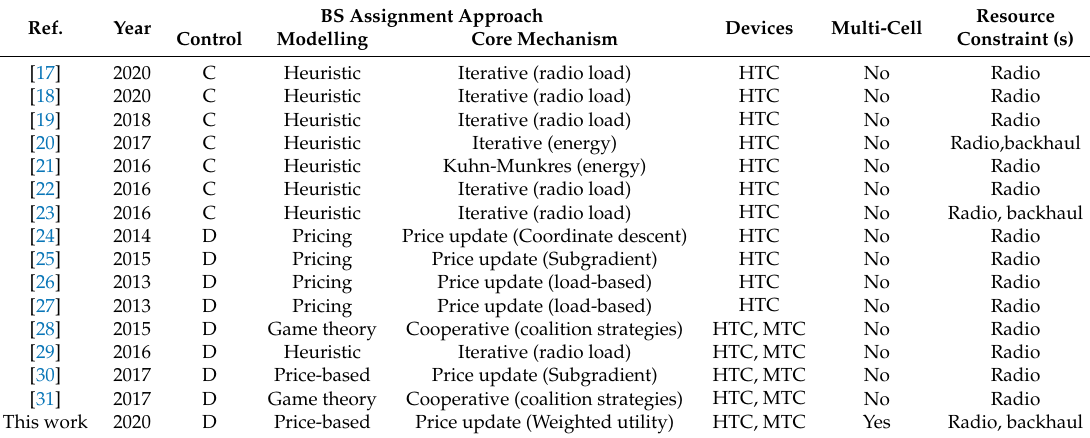
Figure 1. Generic access network architectures under ( a ) centralized and ( b ) distributed paradigms. Table 1. Summary of base station (BS) assignment approaches in centralized (C) and distributed (D)